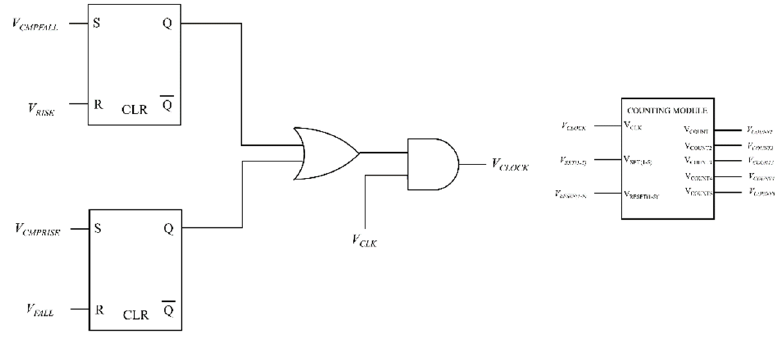
Figure 9. The schematic diagram of the counting control circuit.